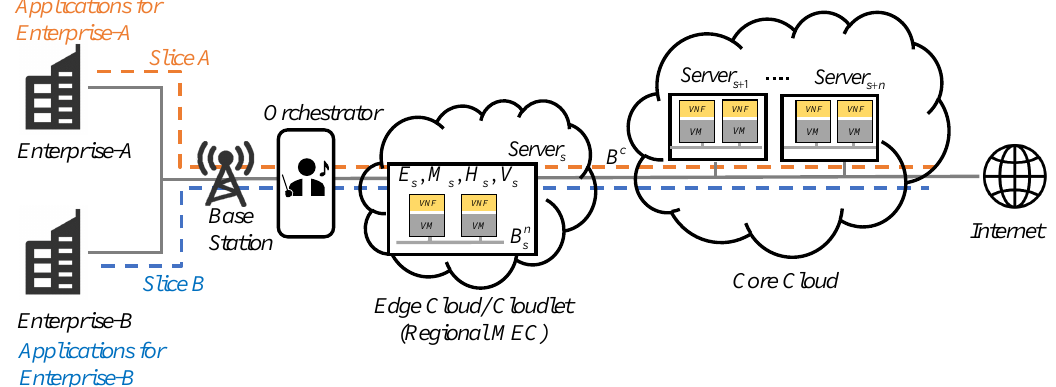
Figure 1. Network topology in slicing